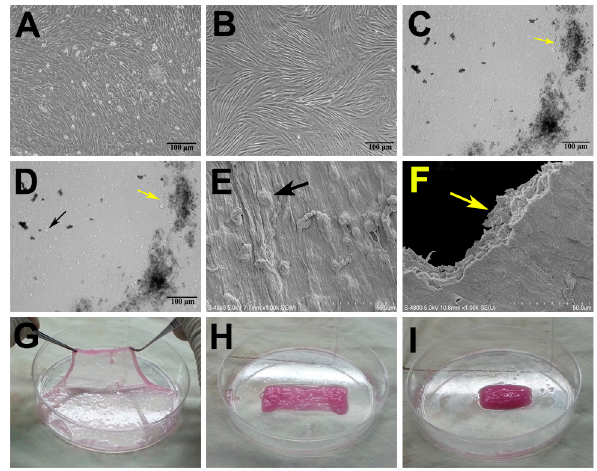
Figure 1. Characterization of adipose-derived stem cells (ADSCs) and mesenchymal stem cell (MSC) sheets. ( A – D ) Phase contrast microcopy. ( A ) MSCs presented a fibroblast-like morphology and closely spaced growth; ( B ) The fusiform ADSCs grew well with a spiral-shaped arrangement; ( C ) After MSCs were cultured in osteogenic medium for two weeks, they grew into multiple layers containing many calcium nodules (yellow arrow); ( D ) ADSCs adhered well to the MSC sheets upon seeding (black arrow); ( E ) Scanning electronic microscopy (SEM) examination demonstrated distinct mineral-like nodules on the surfaces of the cell sheets and the presence of endogenous extracellular matrix (ECM) in the cell sheets (black arrow); ( F ) Section analysis of SEM images of MSC sheets also indicated that they were composed of several layers of cells and their own ECM (yellow arrow); ( G ) MSC sheets could be easily lifted intact from the culture dish; ( H ) folded into a rectangle shape; and ( I ) rolled into a cylindrical construct.